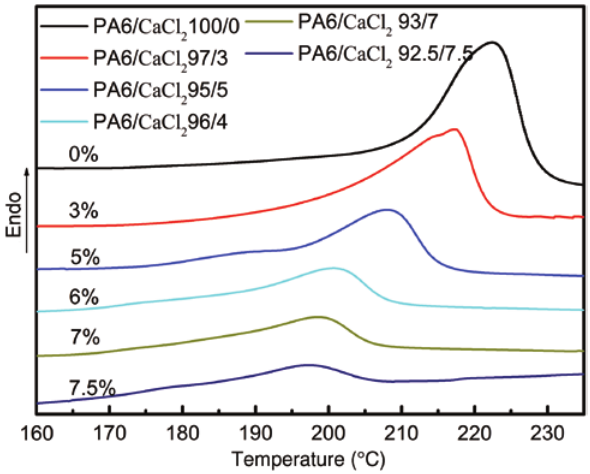
Figure 3 DSC cooling curves of LPA6 with different contents of CaCl 2